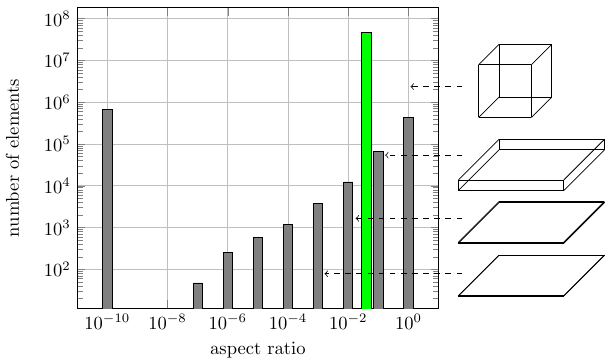
Figure 7. Histogram of aspect ratio classes for reading GOCAD SGrid mesh data (gray) and reconstructed mesh data (green); sam- ple elements for selected aspect